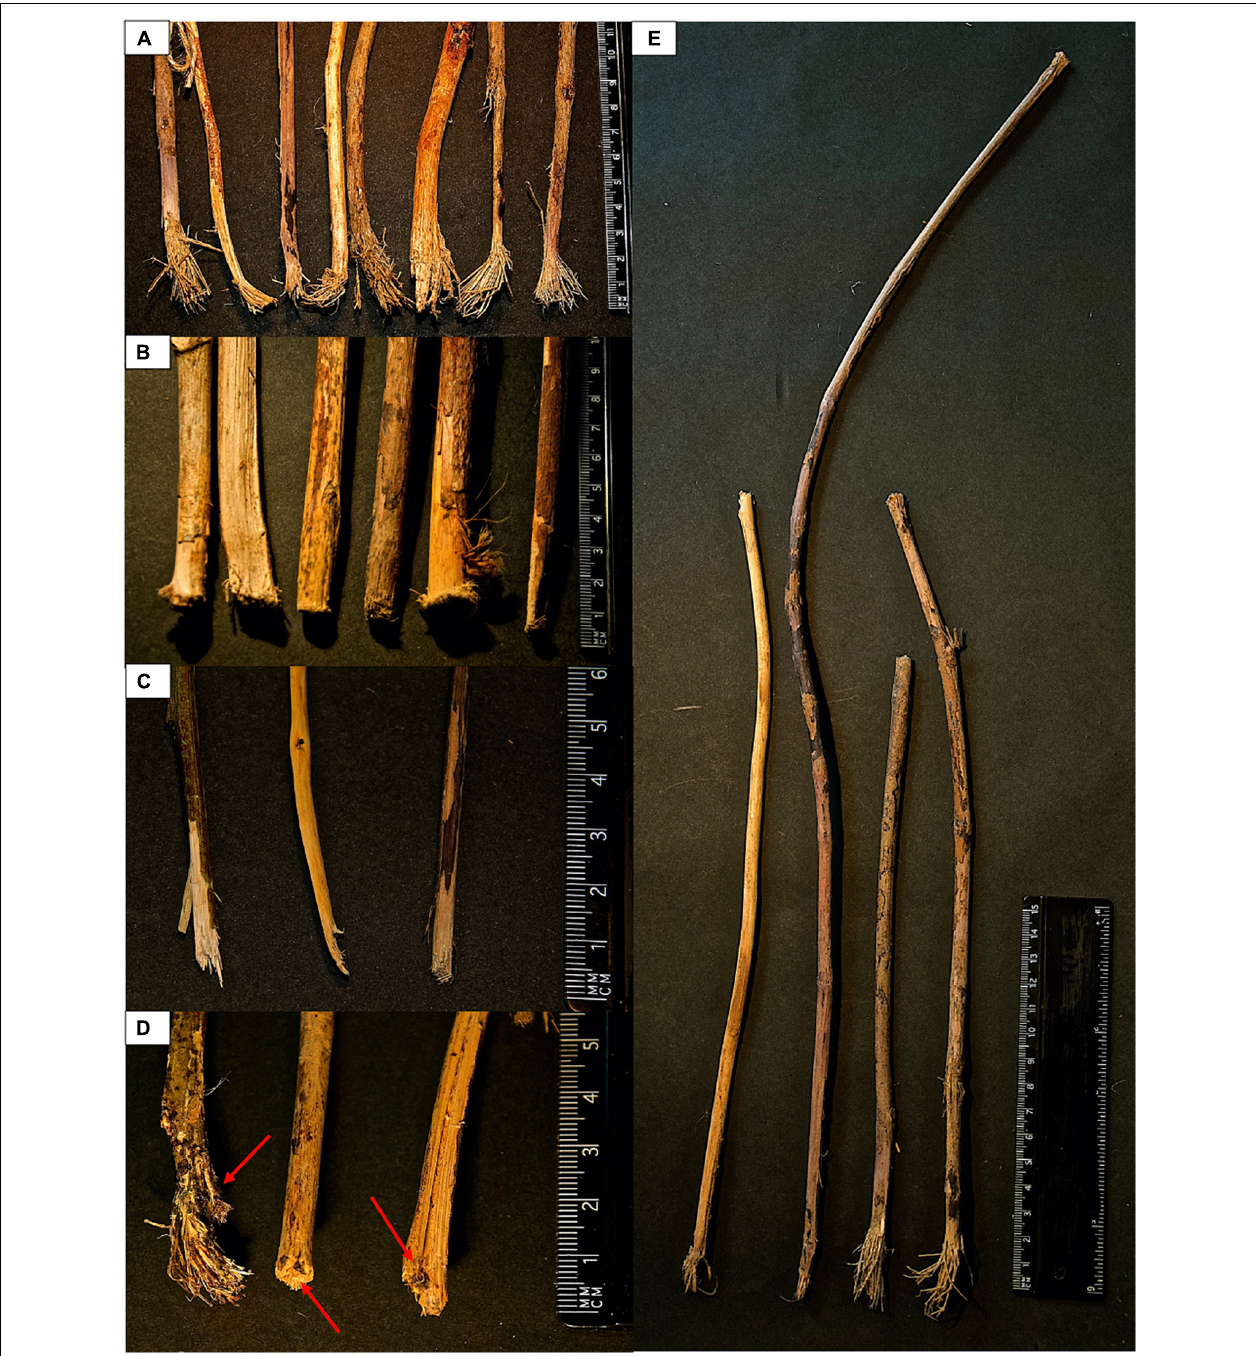
FIGURE 3 | Examples of tools found abandoned in tool use ateliers. (A) Brush tips; (B) blunt tool ends; (C) fragmented tool ends; (D) tool ends with honey residue (indicated by the red arrows); (E) potential multifunction tools with fray/brush ends and blunt/mash ends at opposite tool ends.